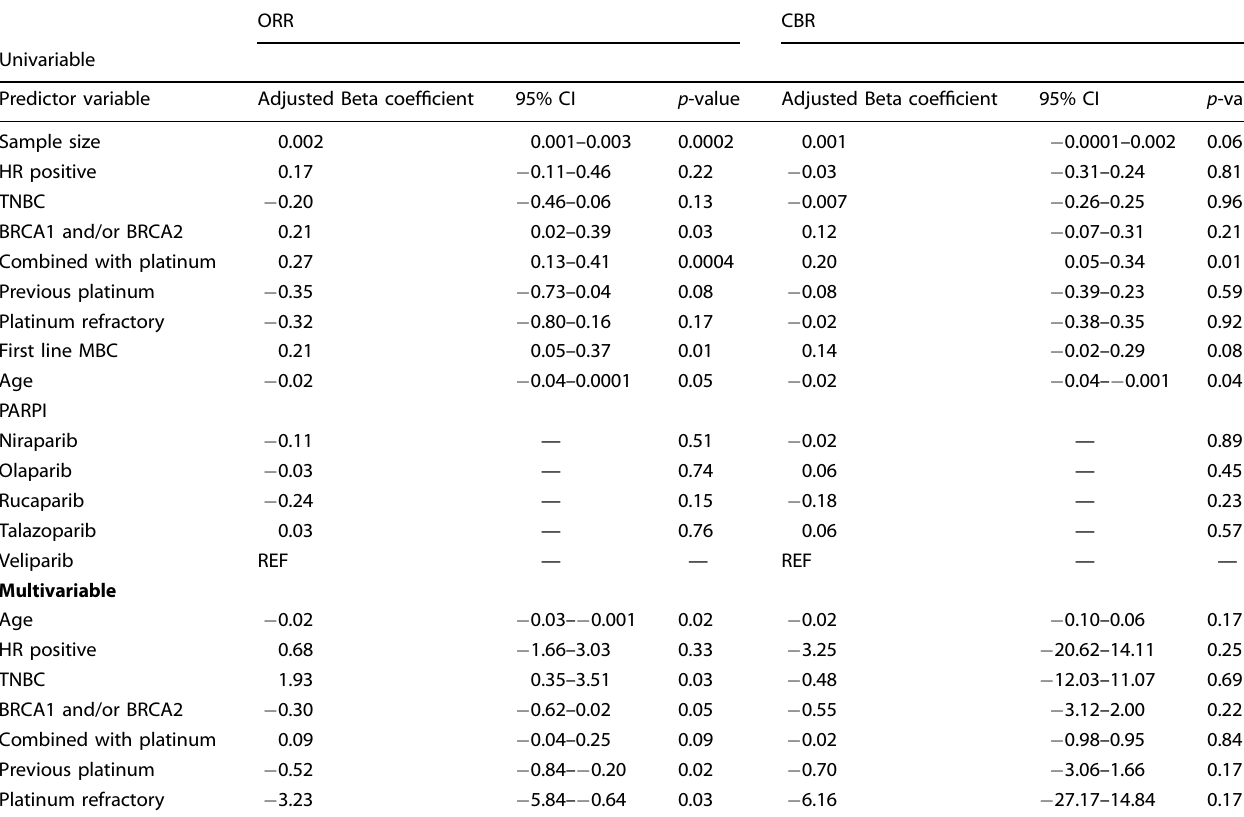
Table 3. Meta-regression analysis for outcomes among included